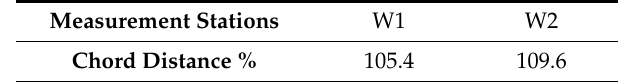
Table 5. Measurement stations of the DCA wake region side as a percentage of the chord